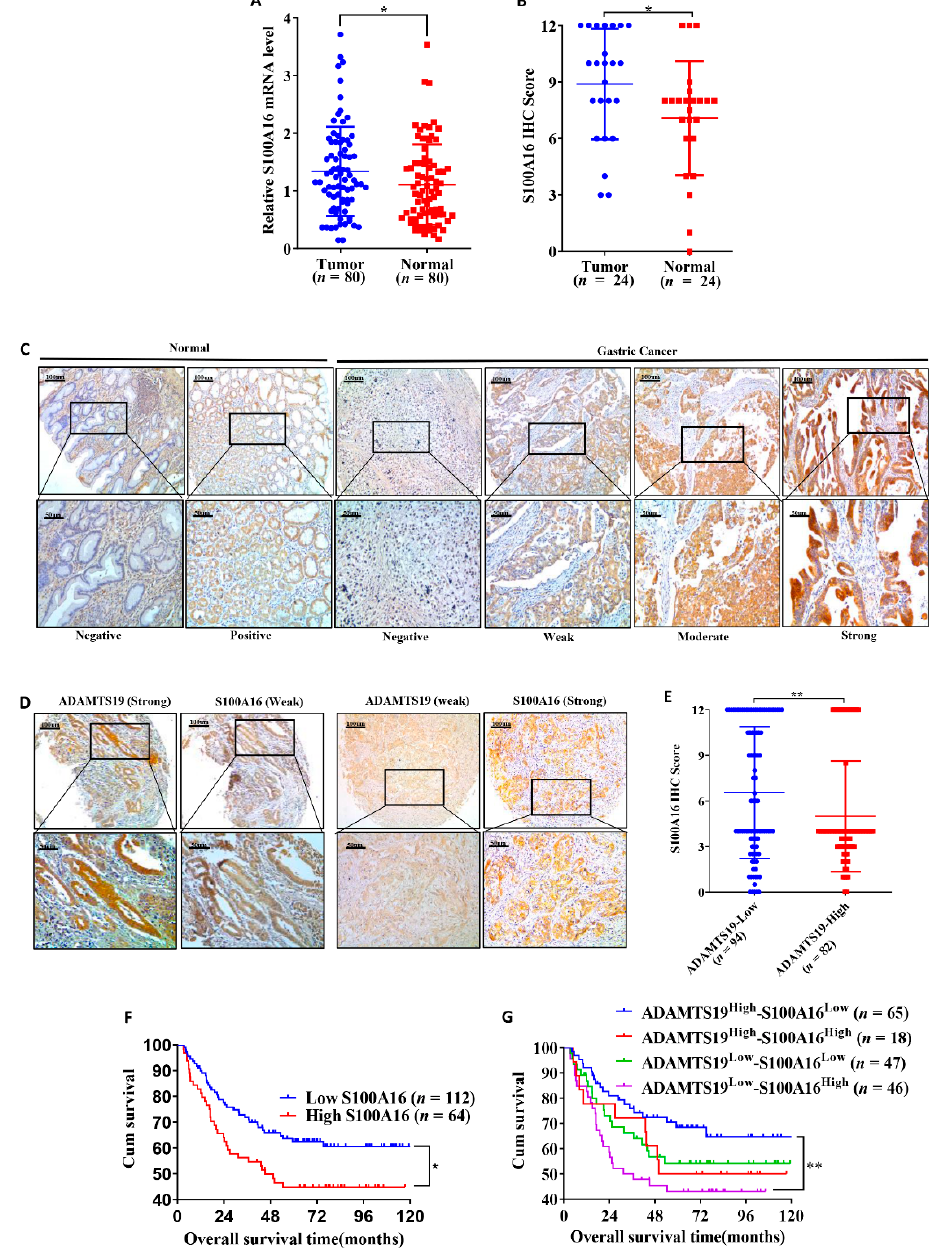
Figure 5. A combination of ADAMTS19 and S100A16 expression predicts the prognosis of GC patients. ( A ) Quantitative RT-PCR on 80 paired GC tissues showed that S100A16 mRNA expres- sion was higher in tumor tissue than in adjacent normal tissue. ( B ) IHC analysis of 24 paired tis- sues showed that S100A16 expression was higher in tumor tissue than in adjacent normal tissue. ( C , D ) Representative IHC images of S100A16 and ADAMTS19 at the same points of tissue micro- arrays. ( E ) The negative correlation between ADAMTS19 and S100A16 was confirmed by IHC. ( F ) High S100A16 expression predicted poorer overall survival than low expression in GC patients (the best cutoff score of 6.0 was obtained using X-tile). ( G ) Survival analysis layered by the expres- sion of ADAMTS19 and S100A16 in tissue microarrays of GC patients showed that ADAMTS19 high -S100A16 low patients had the best overall survival (OS), whereas ADAMTS19 low - S100A16 high patients had the worst OS. * p < 0.05; ** p < 0.01.